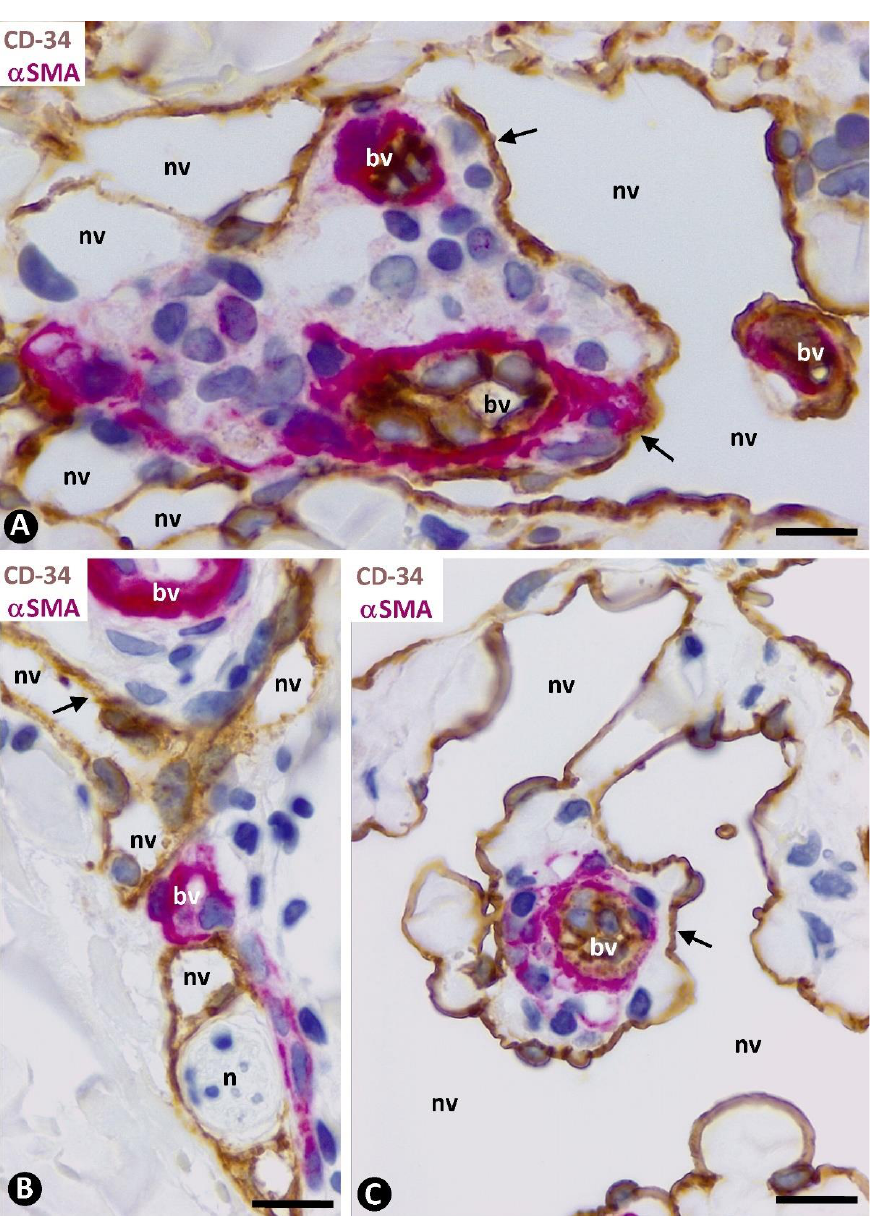
Figure 5. ( A – C ). Neovessels (nv, corresponding to type 1) around pre-existing blood vessels (bv). The precise location of the neovessel ECs coincides with that of the CD34+SCs/TCs in the apparently non-affected blood vessels or with perivascular inflammatory infiltrate (arrows) (compare with Figures 3 and 4). Note that the pre-existing blood vessels (bv, with α SMA+ pericytes or vascular smooth muscle cells, red) are totally or partially surrounded by the neovessels (without pericytes or vascular smooth muscle cells), giving rise to the image of a vessel within a vessel (promontory sign). Double immunochemistry for CD34 and α SMA. Hematoxylin counterstain. Bar: ( A ): 15 µ